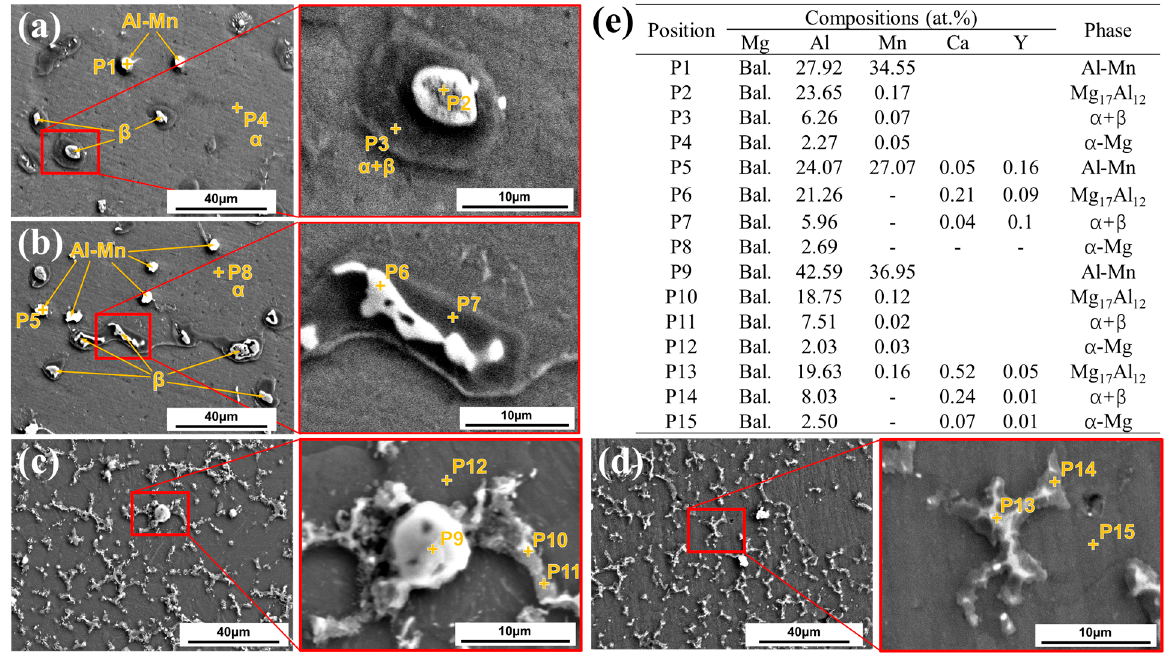
Figure 2. SEM images of ( a ) GC AM60 alloy, ( b ) GC AMXW6000 alloy, ( c ) HPDC AM60 alloy, ( d ) HPDC AMXW6000 alloy, and corresponding ( e ) EDS results in ( a – d ),